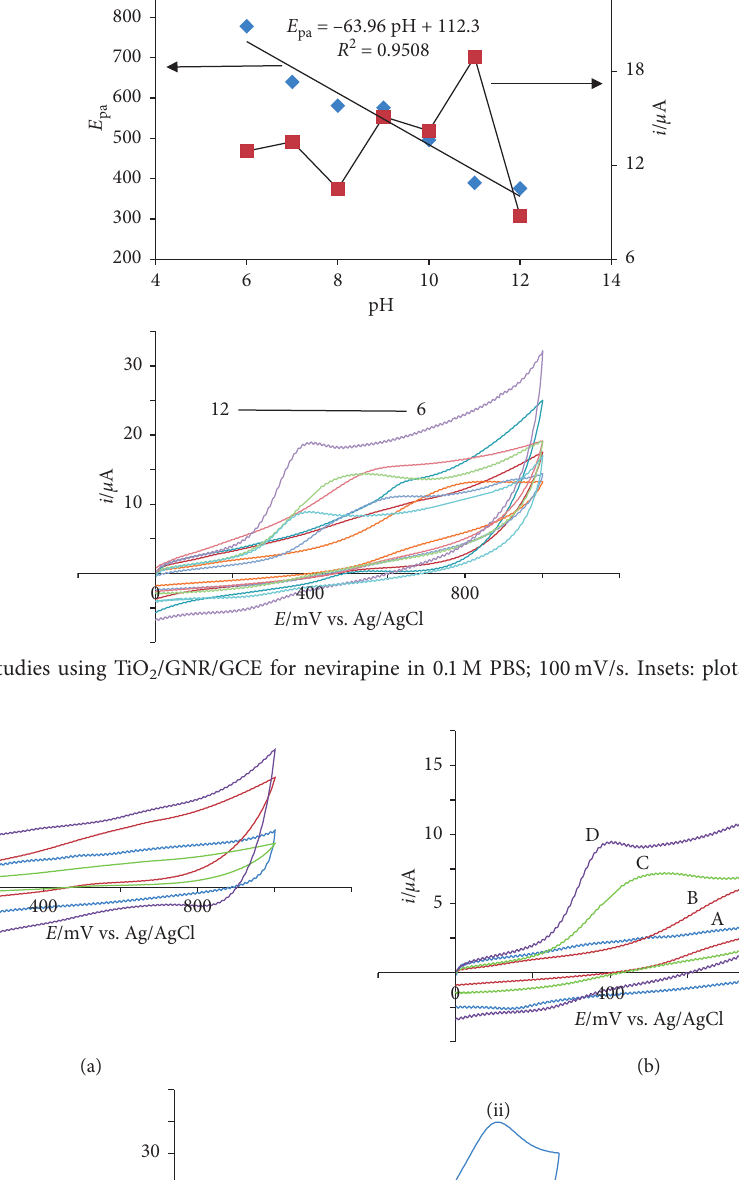
2 /GCE, (c) GNR/GCE, and (d) TiO 2 /